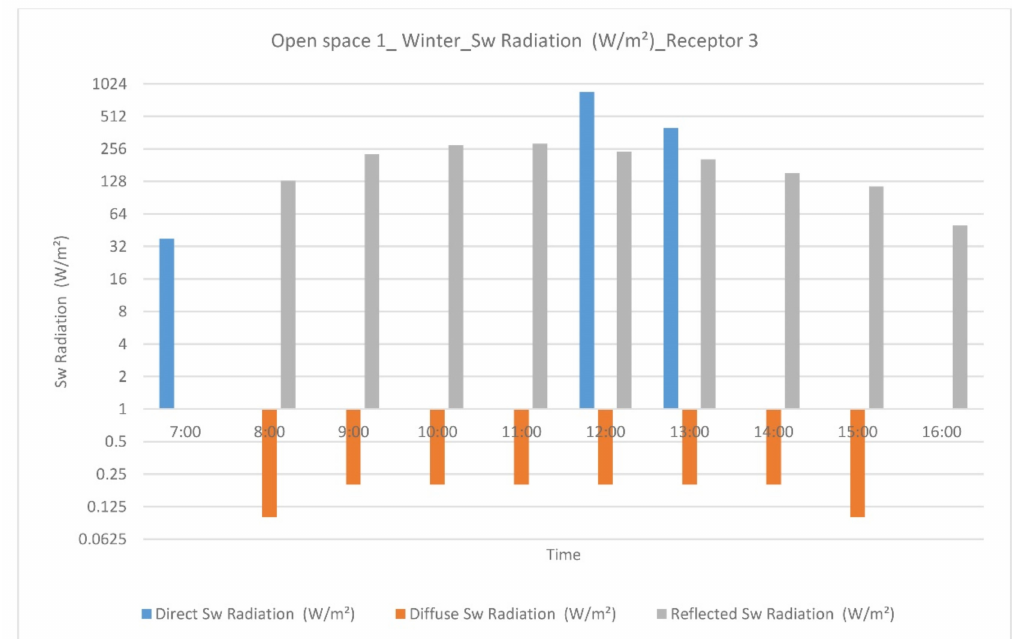
Figure A4. Open space 1 solar radiation in winter at receptor